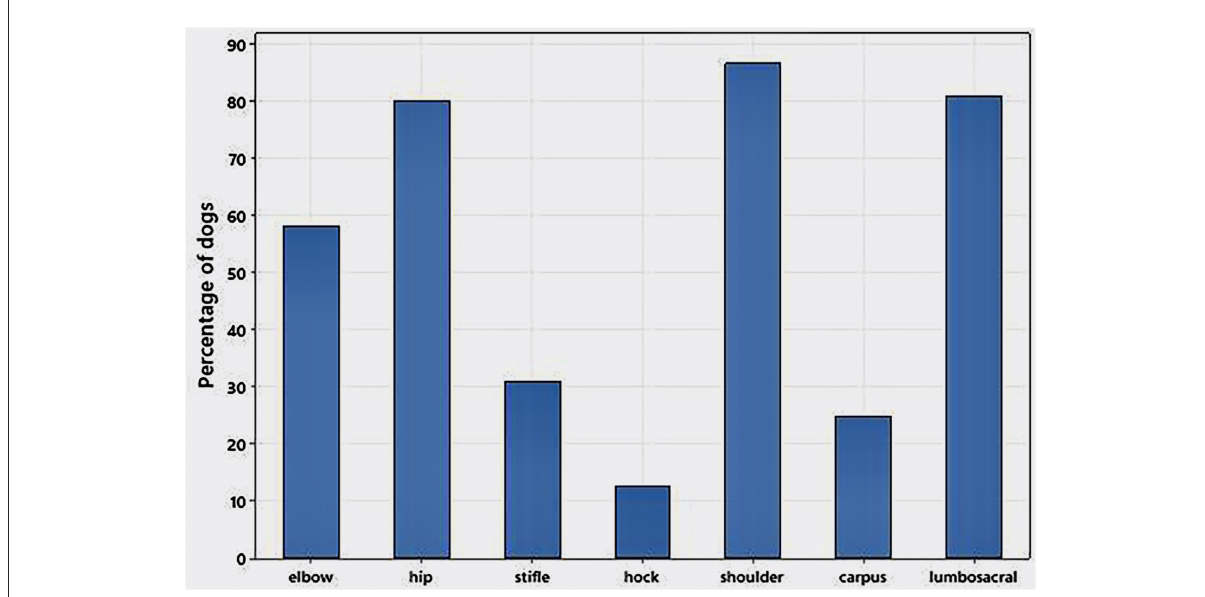
FIGURE3 Proportion of 245 dogs with MSD treated with corresponding regenerative medicine to 104 weeks that received joint or lumbosacral treatments on at least one occasion. Multiple joints were treated in 89% of dogs and < 1 % of dogs had only a single musculoskeletal disease